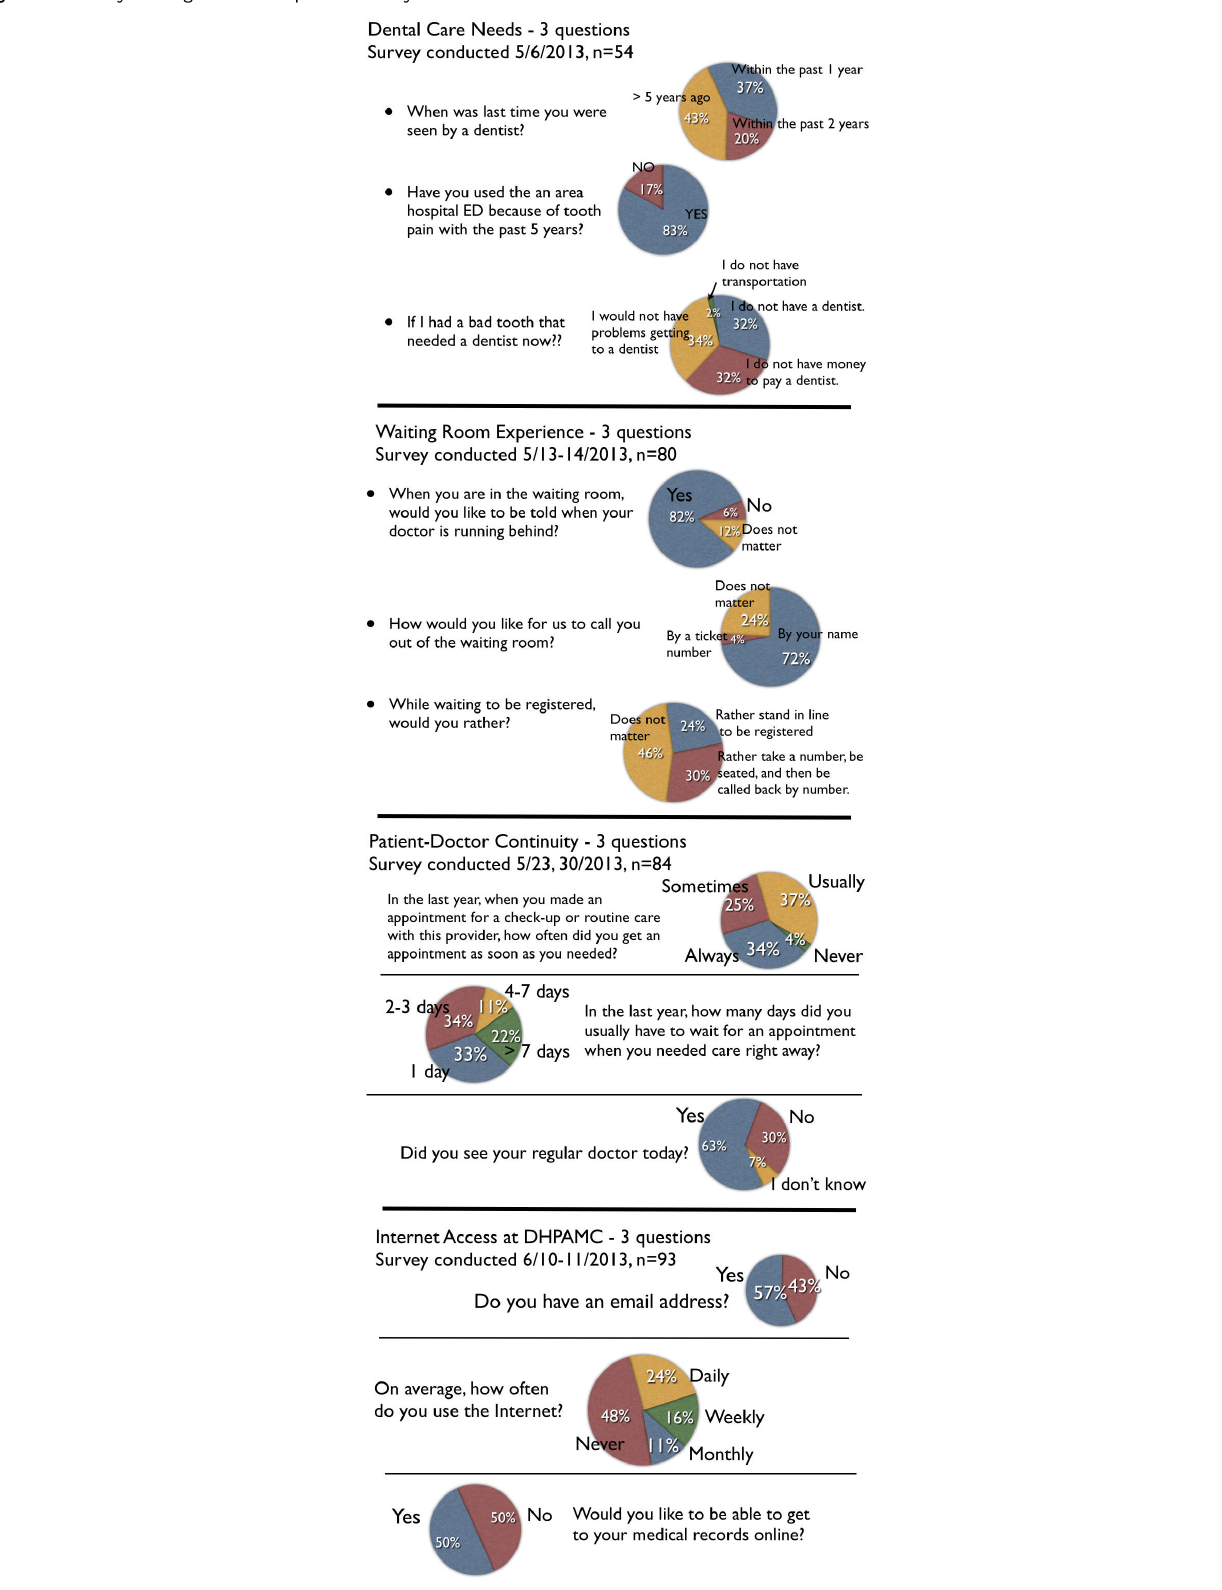
Figure 1. Survey findings from four patient